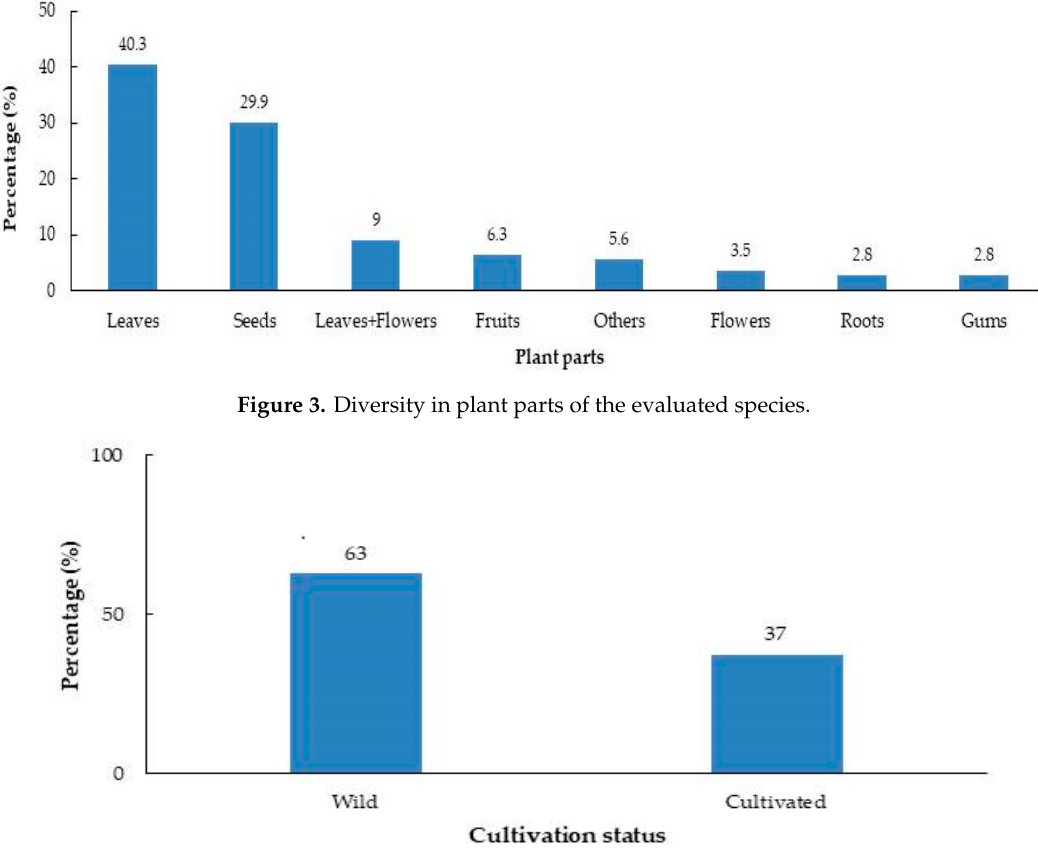
Figure 4. Cultivation status of the medicinal plants evaluated in this study.